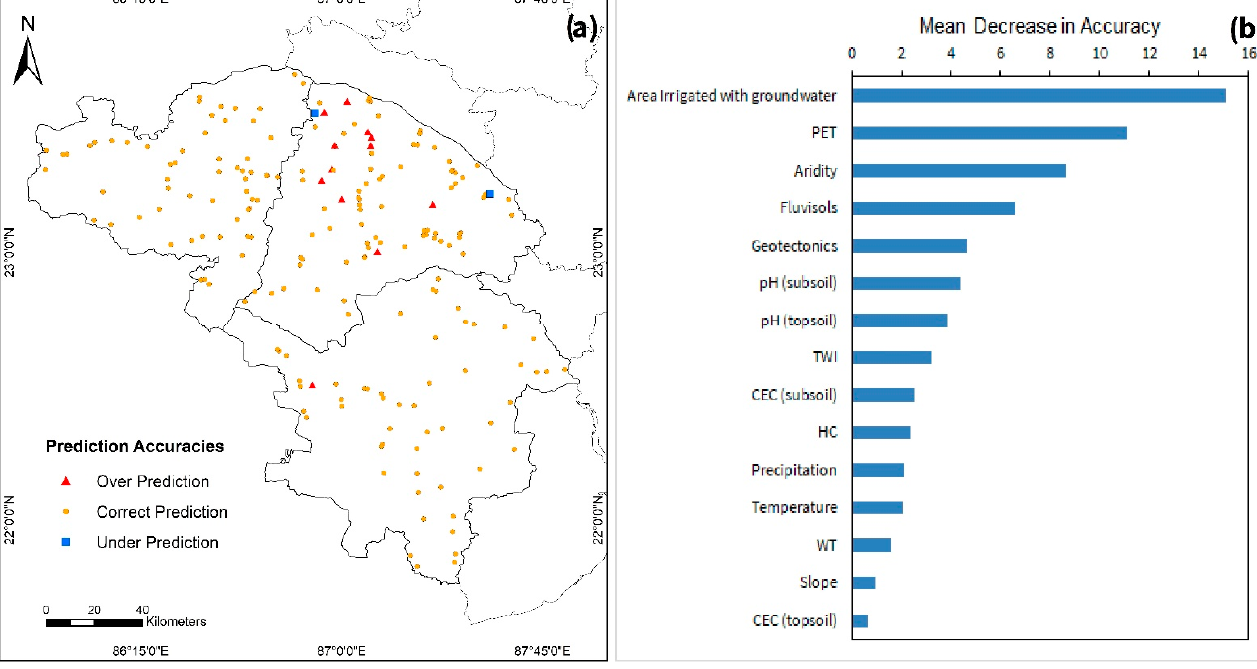
Figure 4. ( a ) Map showing the accuracies of the groundwater F prediction; ( b ) mean decrease in accuracy of the predictor variables: PET—Potential Evapotranspiration, TWI—Topography Wet- ness Index, HC—Hydraulic Conductivity, WT—Depth to Water Table, and CEC—Cation Exchange Capacity.